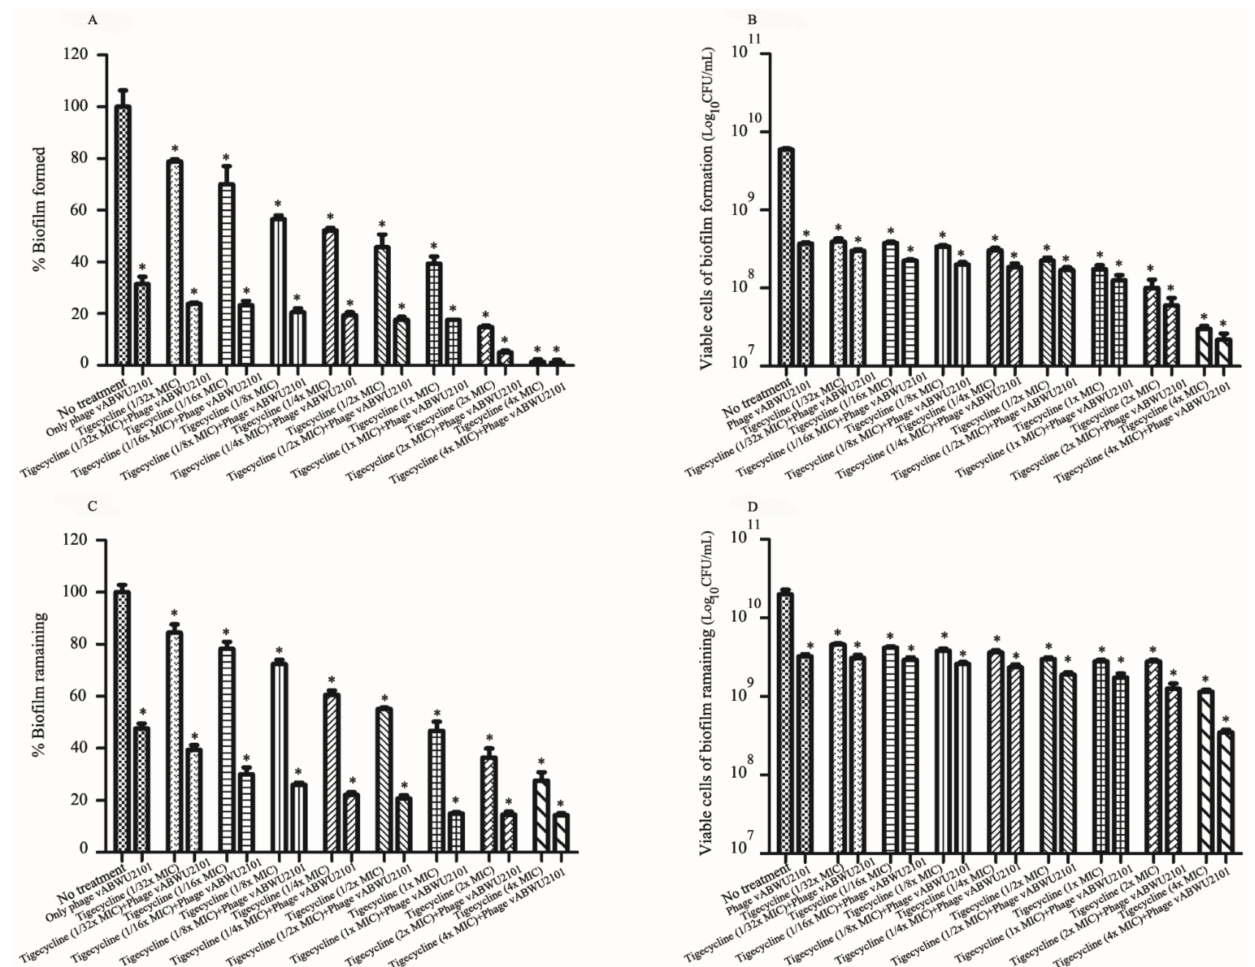
Figure 9. Antibiofilm activity of synergistic combinations of phage vABWU2101 and tigecycline. Biomass ( A ) and bacterial cell viability ( B ) of MDR A. baumannii biofilm formation treated with a combination of phage vABWU2101 at an MOI of 1 and tigecycline at 1/32–4 × MIC. Biomass ( C ) and bacterial cell viability ( D ) of MDR A. baumannii preformed biofilms treated with a com- bination of phage vABWU2101 at an MOI of 1 and tigecycline at 1/32–4 × MIC. The effects of a combination of phage vABWU2101 and tigecycline on biofilms were determined by crystal violet assay. The effect of a combination of phage vABWU2101 and tigecycline on the bacterial cell